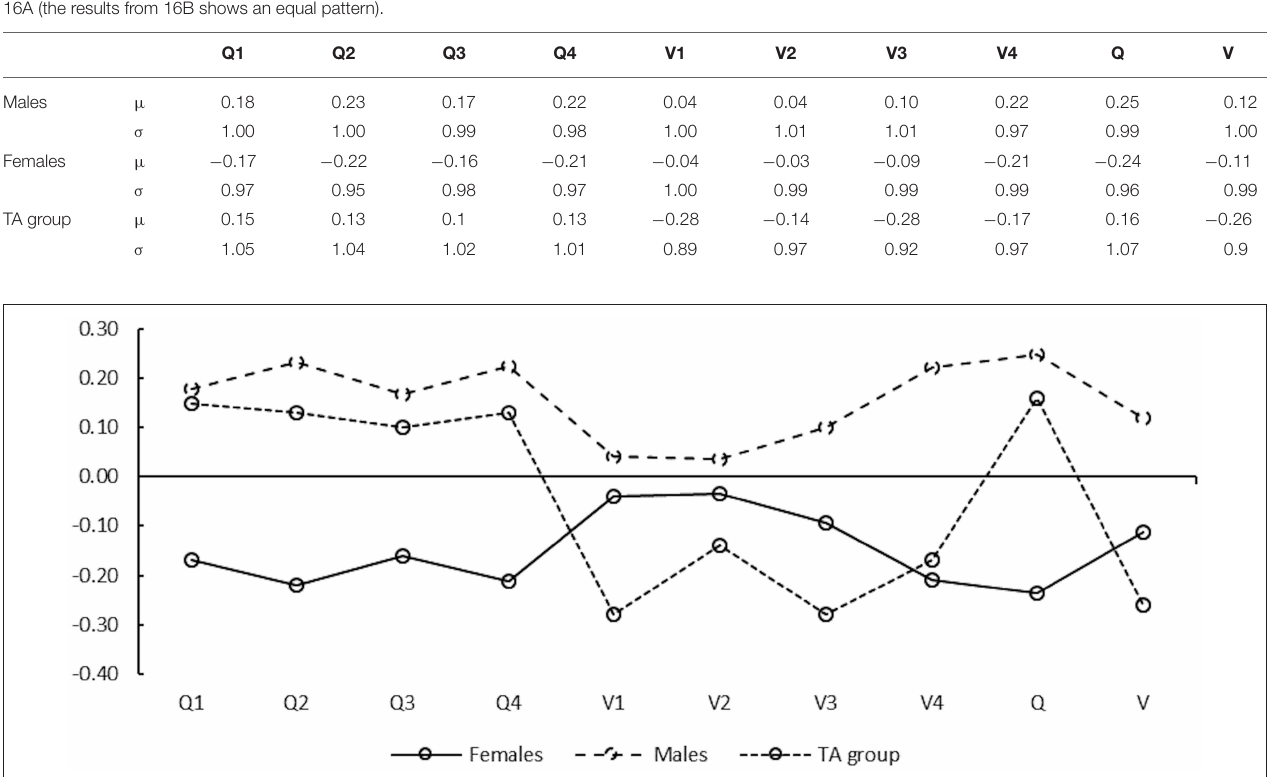
FIGURE 1 | Standardized subscore means for test-takers with time accommodations (TA group), Males and